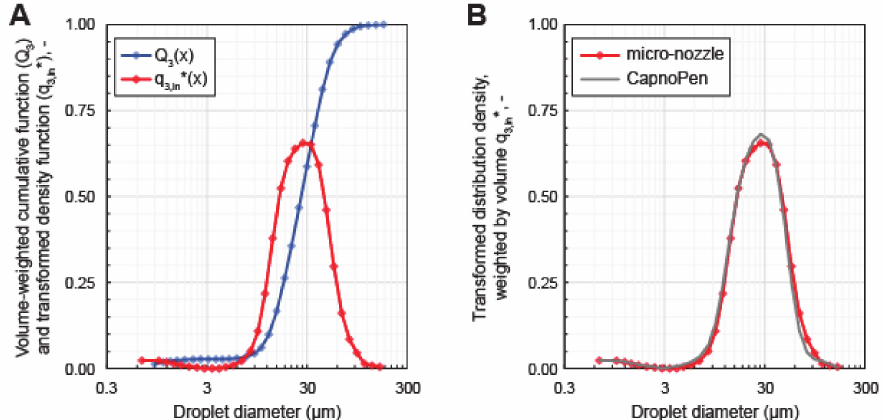
Figure 4. Granulometric analysis. ( A ) Volume-weighted droplet size distribution of the micro-nozzle (means, n = 3) as measured by laser di ff raction spectrometry. ( B ) Comparison of the volume-weighted droplet size distributions of the micro-nozzle (based on aerosolization of a 0.9 wt.-% aqueous sodium chloridesolution(presentstudy)tothatofthestandardPIPACnozzlefortheuseinhumans(CapnoPen ® , operated with a 5.0 wt.-% aqueous glucose solution as reported in [16]). Graphical representation according to ISO 9276-1:1998